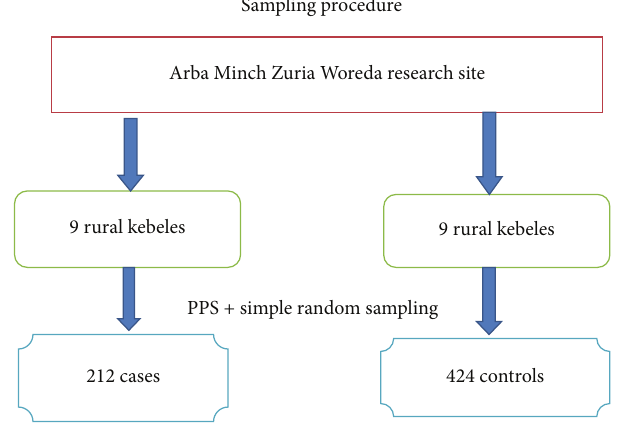
Figure1:SchematicpresentationofsamplingprocedureforQuanti- tative study among child-bearing age group mothers in Arba Minch Zuria Woreda, SNNPs, Ethiopia,